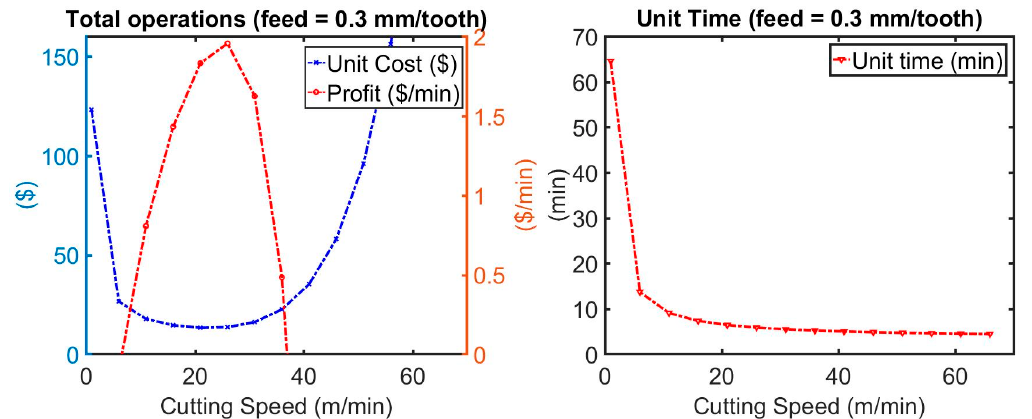
Figure 5. Plot showing profit, unit cost, and unit time for all operations examined in the case study assuming a constant feed of 0.8 mm/tooth.